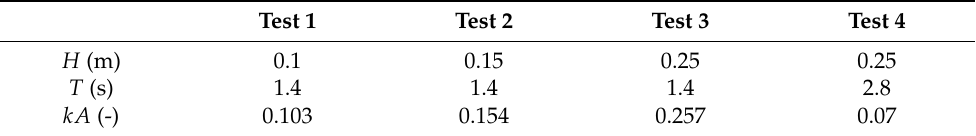
Table 1. Wave conditions considered for the validation of Wavestar. Test